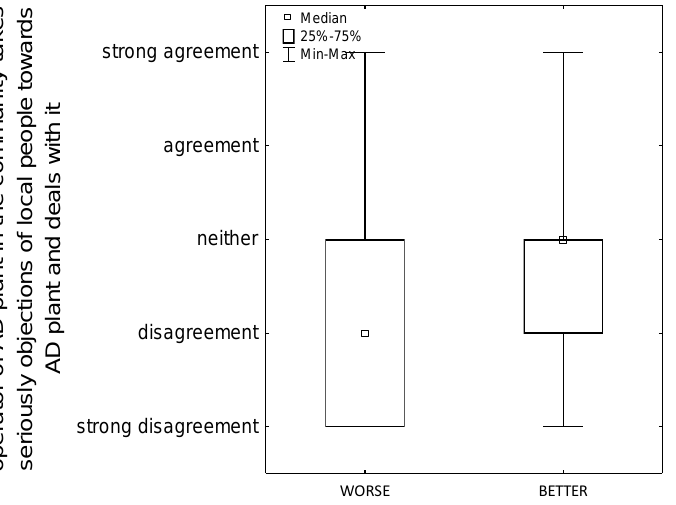
Figure 6. The level of agreement with how seriously the operator of the AD plant in their community takes objections of local people towards the AD plant and deals with them.